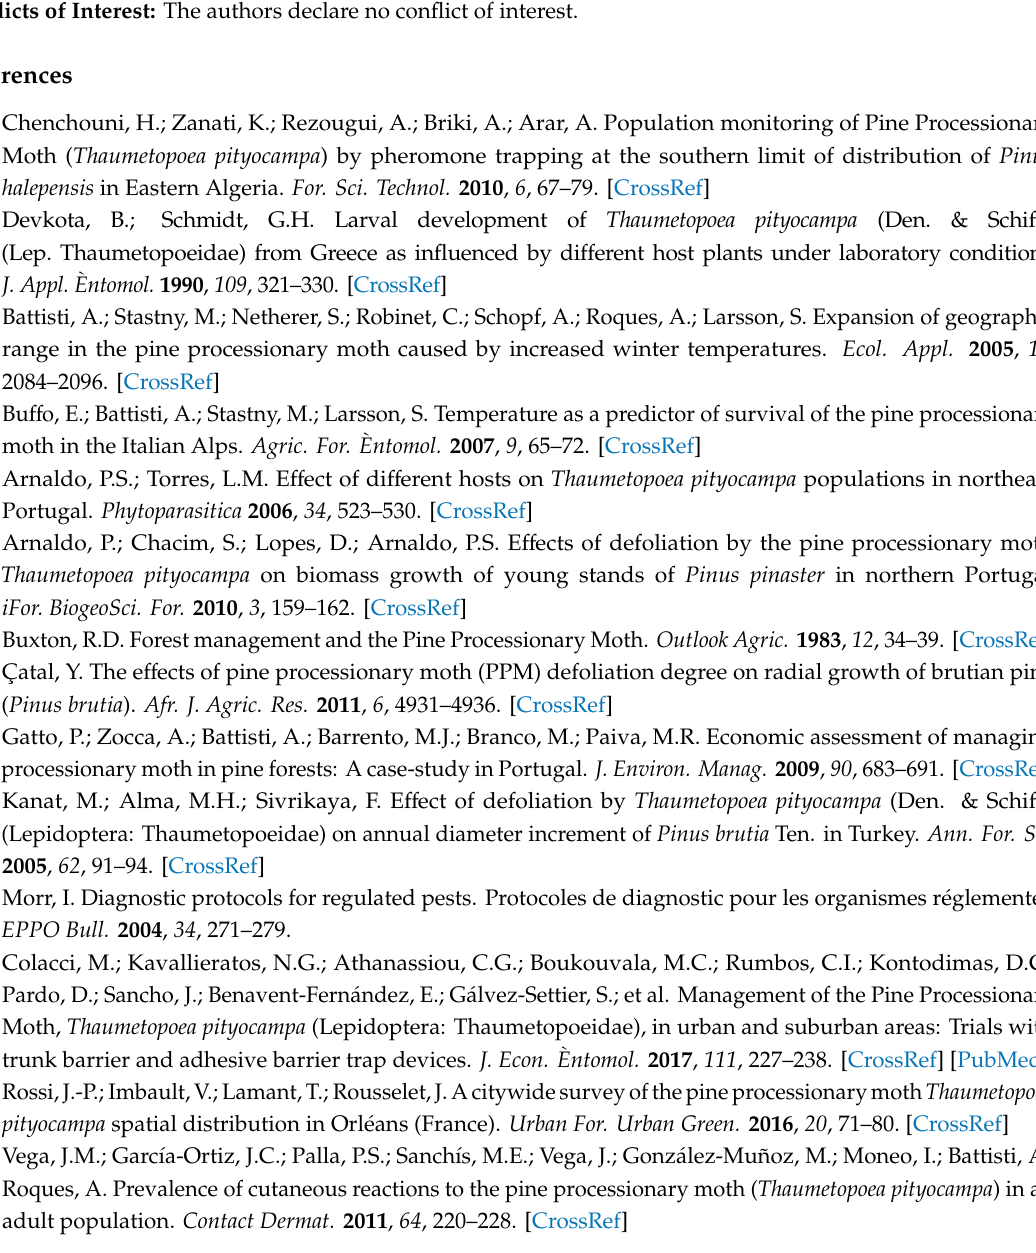
Table S1: List of the monitored municipalities in Aosta Valley in 2015–2019, Table S2: Total number of male adults of Thaumetopoea pityocampa monitored with pheromone-baited traps in Aosta Valley in